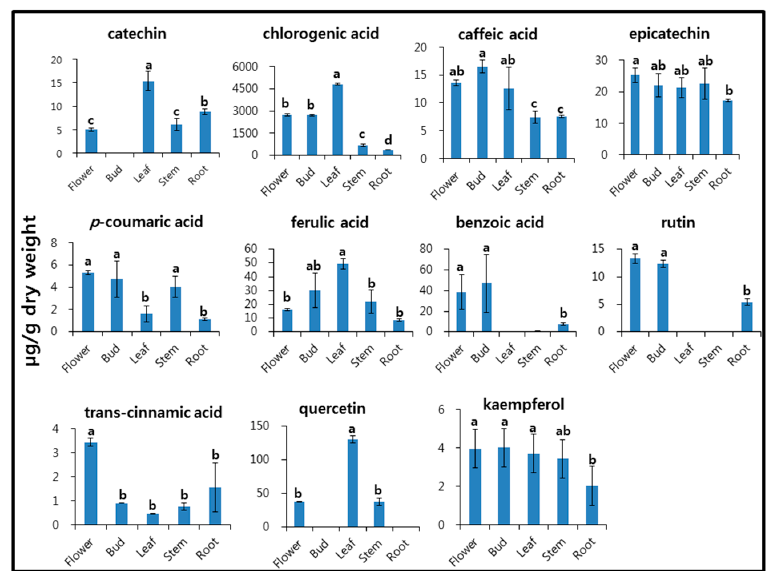
Figure 2. Accumulation of phenolic compounds in different organs of I. dentata . Each value is the mean of three biological replicates, and error bars indicate standard deviation. Lower-case letters indicate statistically significant differences ( p < 0.05) between different organs according to Duncan’s Multiple Range Test ( n = 5).